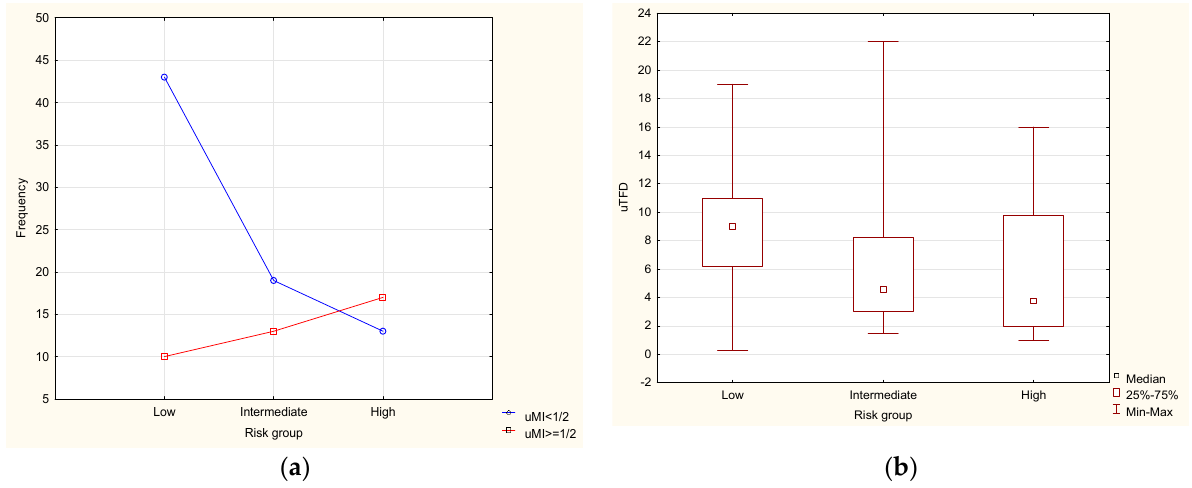
Figure 3. Frequency of patients in risk groups according to uMI ( p = 0.00172 for chi-square test of independence) ( a ), and box-plots of distributions of uTFD for risk groups (Kruskall–Wallis ANOVA p = 0.0006) ( b ). Post hoc analysis (Table S3) shows that differences between all the groups are signif- icant: with the increase of risk, the mean rank value of uTFD decreases. In Figure 3b, the median values are shown. Survival Analysis and Ultrasound Biomarkers Comparing the survival curves for uMI (less than, or equal to, or greater than 1/2 or 50%) and uTFD (less than, or equal to, or greater than 5.2 mm) cases showed no statisti- cally significant differences (Figures S3-S4). Figure S5 shows complete and relapse-free survival for the groups with and without lymphatic metastases. The differences in sur- vival are statistically significant for overall survival, but they are of borderline significance for relapse-free survival. 4. Discussion The aim of the study was to test the predictive power of ultrasound biomarkers (uMI, uTFD) of uterine infiltration currently used to determine the risk of lymph node metasta- sis in endometrial cancer, taking into consideration endometrial cancer risk groupings and recurrence-free and overall survival.